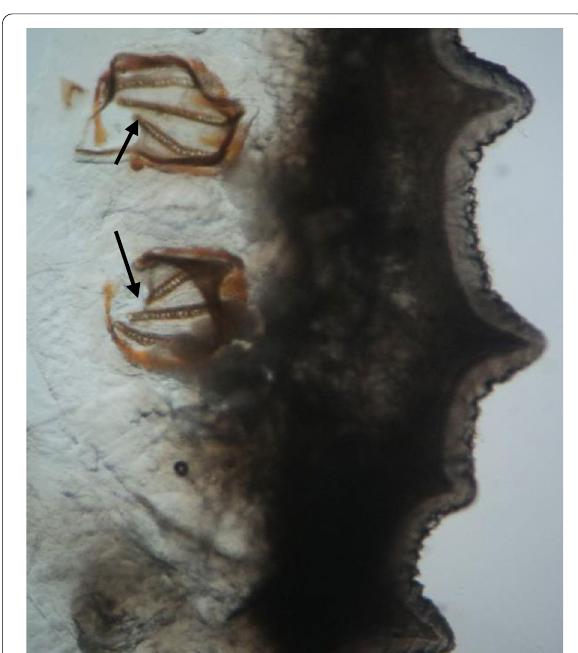
Fig. 3 Microscopic features of posterior spiracle of Sarcophaga spp ( 100 magnification). Arrow mark: posterior spiracle inside deep × cavity; incomplete peritreme lacks button; stigmal slits directed away from peritreme opening